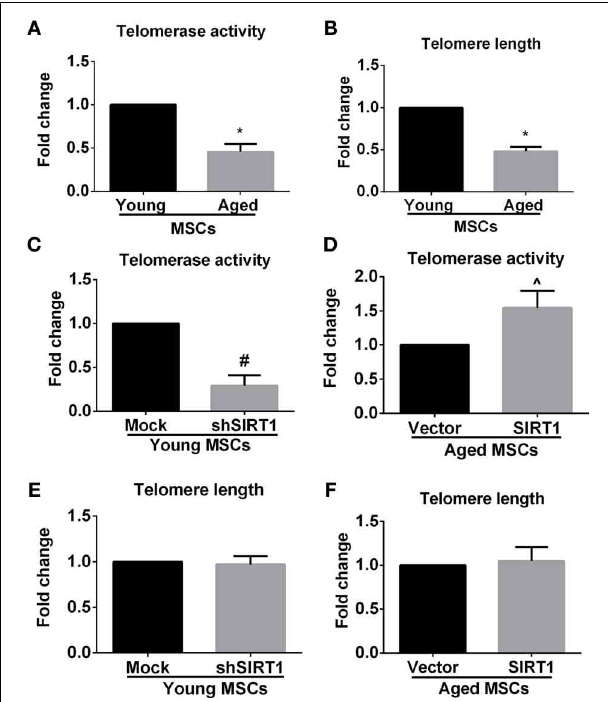
FIGURE 5 | SIRT1 modulates telomerase activity, but not telomere length in MSCs. Quantitative analysis of age-related alterations of telomerase activity (A) and telomere length (B) in MSCs was shown. Quantitative analysis of telomerase activity in young (mock- and shSIRT1-) (C) and aged (vector- and SIRT1-) MSCs (D) was also shown. Quantitative analysis of telomere length in young (mock- and shSIRT1-) (E) and aged (vector- and SIRT1-) (F) MSCs was shown. No siginificant change in telomere length was observed when SIRT1 was manipulated in young or aged MSCs. Data are expressed as mean ± SD (three independent experiments, n = 5 rats/group). ∗ Signifies P < 0 . 05, compared to young MSCs. #, P < 0 . 05, compared to mock-young MSCs. ∧ , P < 0 . 05, compared to vector-aged